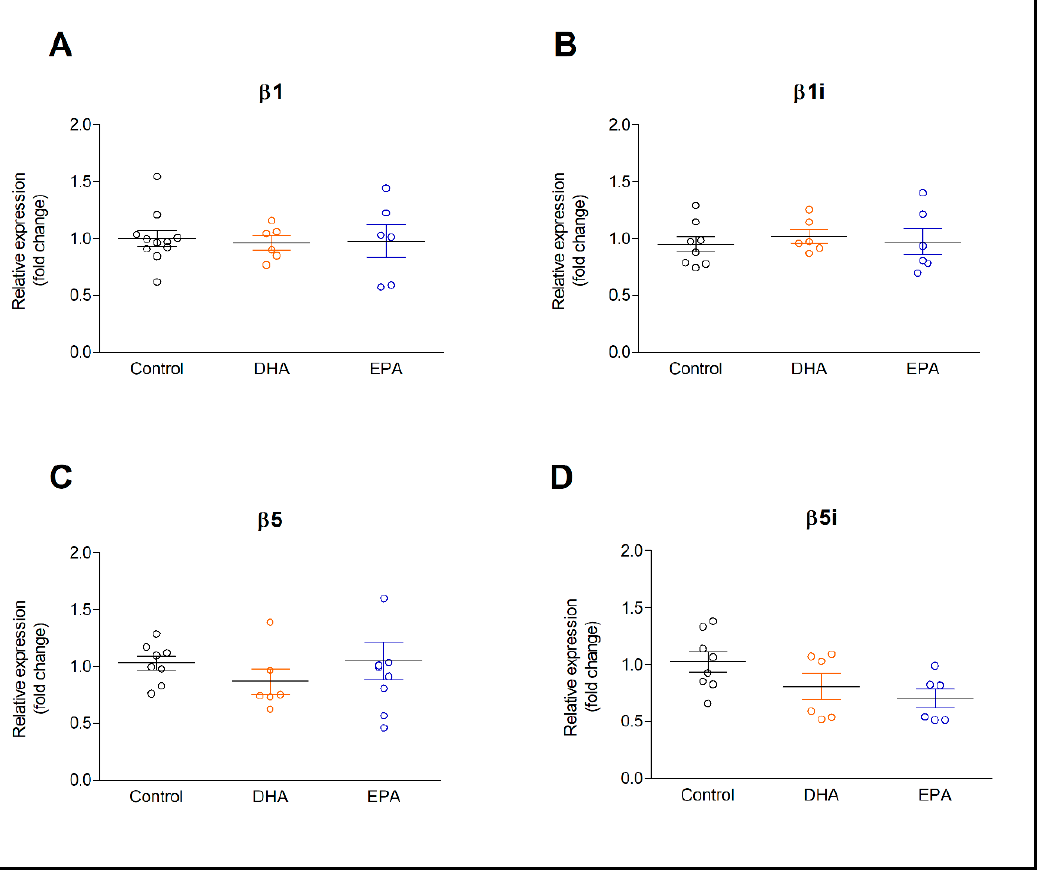
Figure 1. The effect of DHA and EPA (at concentration of 30 µM) on β 1 ( A ), β 1i ( B ), β 5 ( C ), and β 5i ( D ) proteasome subunits expression in rat astrocytes. Treatment protocol is described in the Methods section.